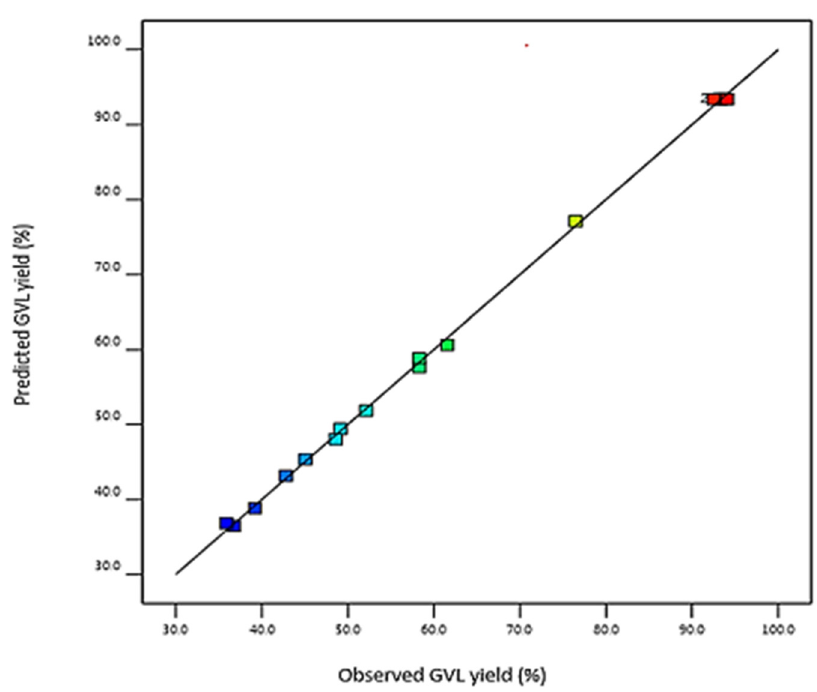
Figure 2. GVL parity plot that compares the predicted GVL yield with experimental GVL yield. The pareto chart illustrates which of the investigated parameters have a greater influence on GVL yield. Figure 3 shows that temperature ( B ) had the greatest effect, compared to time ( A ) and catalyst loading ( C ). The p values in Table 3 show that all the investigated parameters are significant, but the interaction of temperature and catalyst loading ( BC ) has minimal effect on GVL yield.